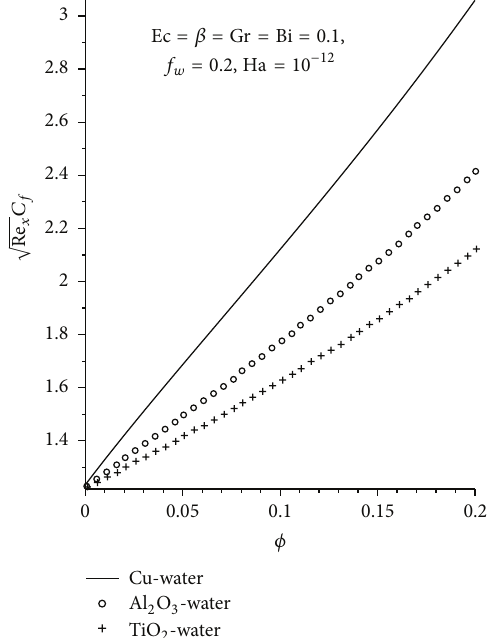
Figure 10: Effects of increasing 𝛽 and 𝑓 𝑤 on local skin friction. velocity gradient at the plate surface. As expected, increasing Ha, Gr, Ec, and 𝑓 𝑤 leads to an increase in the skin friction coefficient, while an increase in 𝛽 reduces the skin friction coefficient as shown in Figures 9 and 10. There is an increase in the rate of heat transfer with an increase in 𝜑 , Bi, and 𝑓 𝑤 as seen in Figures 11-12, with Al 2 O 3 exhibiting the highest increment. The converse is seen with increasing Ha as shown in Figure